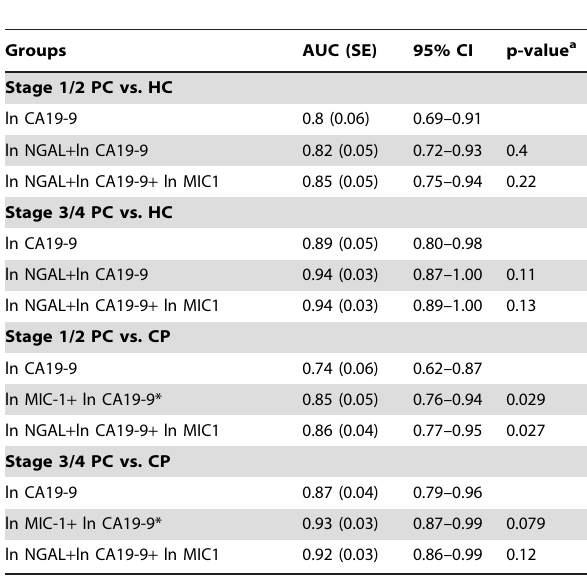
Table 5. Comparison of Area under the ROC curve for NGAL, MIC-1 and CA19-9 in the diagnosis of pancreatic cancer ? .